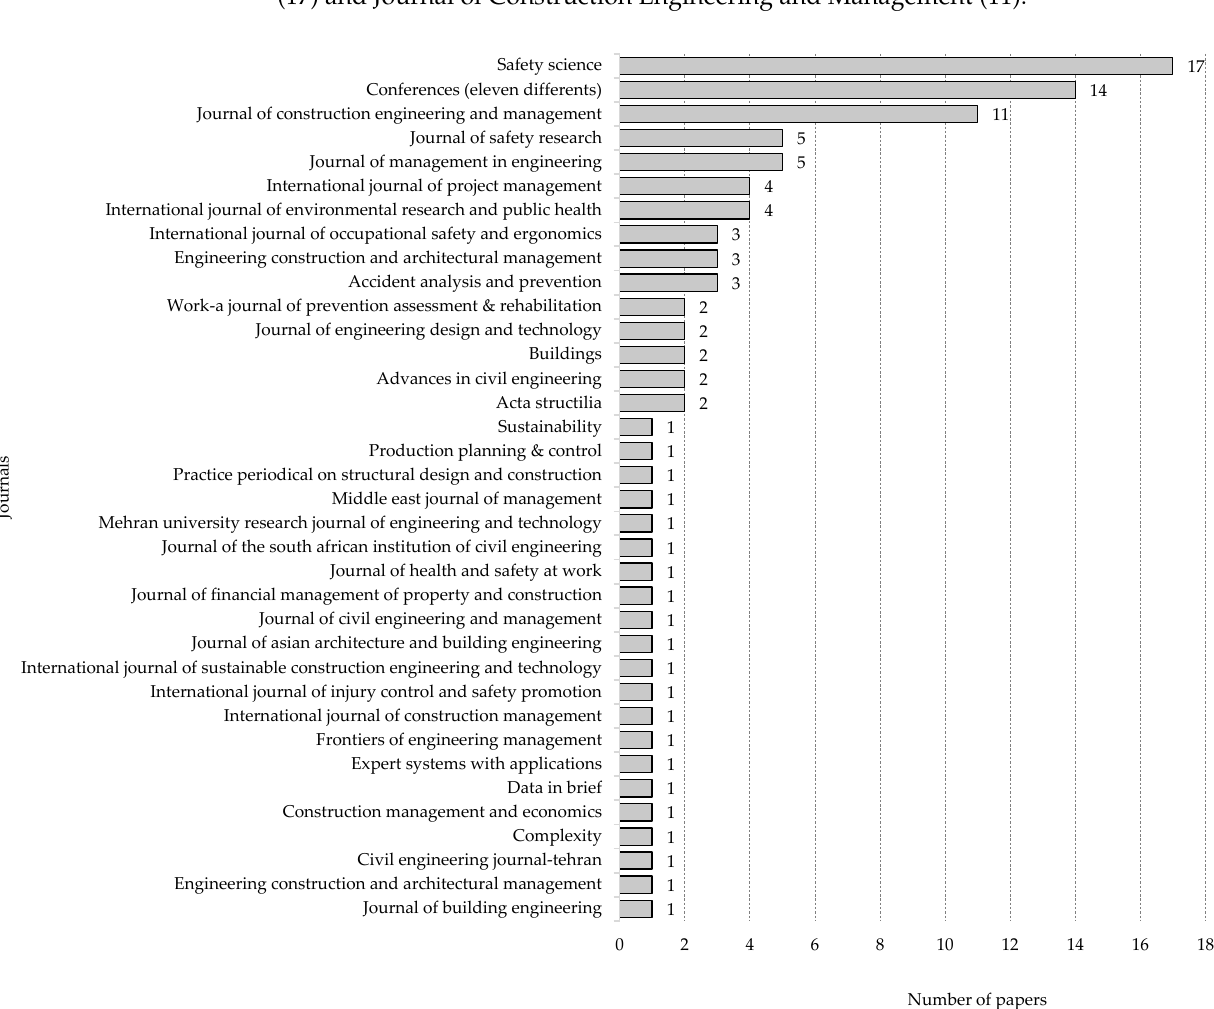
Figure 3. Annual distribution of papers. Figure 4 shows the journal titles and the number of articles found for each of them. Of the total number (100) of articles, 86% corresponded to journal articles and 16% to conference articles. The journals with the highest number of articles were Safety Science (17) and Journal of Construction Engineering and Management (11).